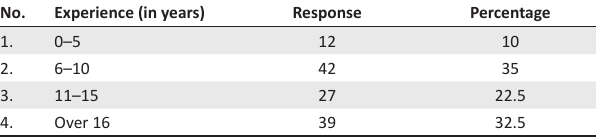
TABLE 1b: Demographic profile of respondents (Section